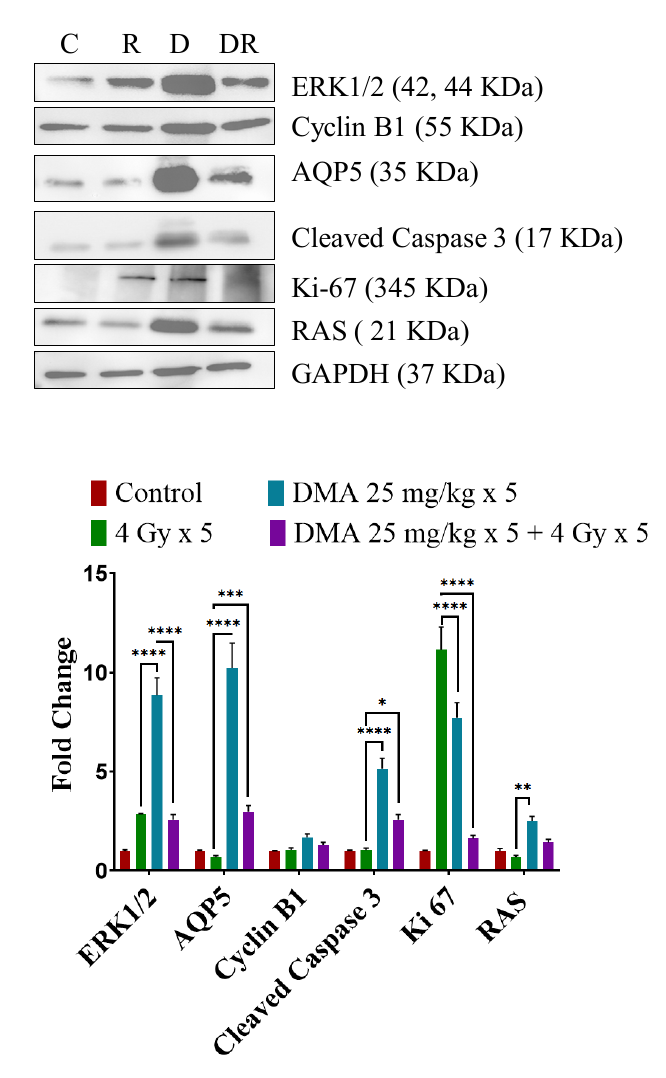
Figure 7. Differential regulation of downstream effector proteins in response to DMA treatment.